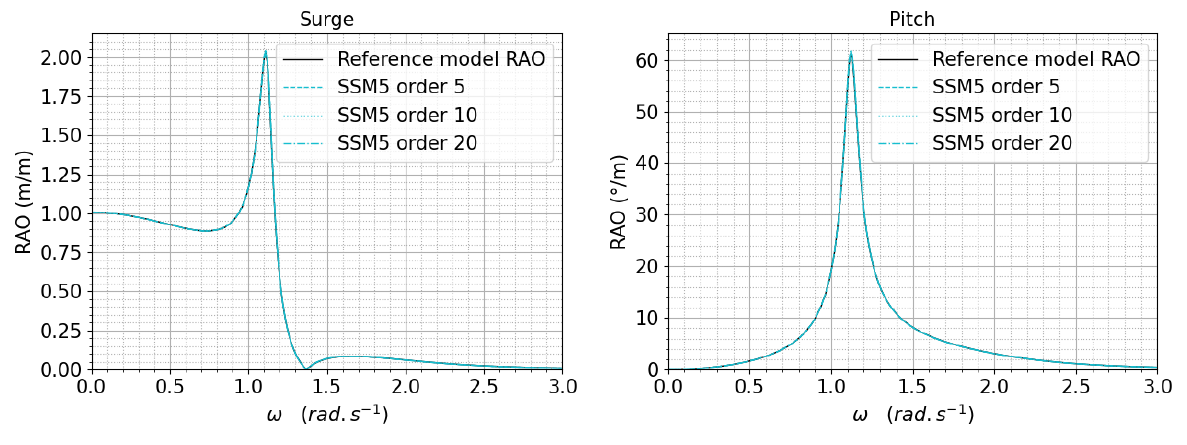
Figure 13. Comparison between SSM5 and the reference RAO for surge and pitch